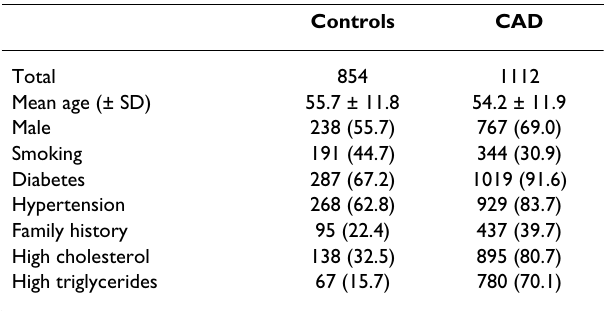
Table 1: Clinical and demographic characteristics of the control and CAD groups Controls